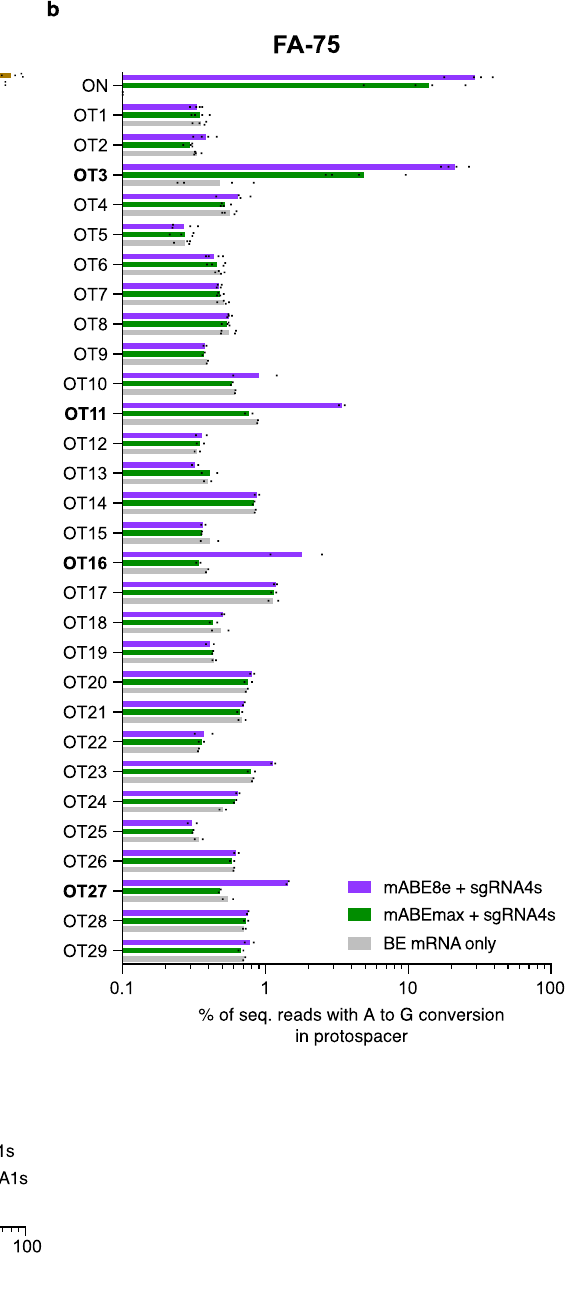
Fig. 4 | Off-target analysis at predicted loci in FA-55 and FA-75 LCLs. Compu- tationallypredictedoff-targetsitesareshownforFA-55sgRNA1 a andFA-75sgRNA4 b . The Sum of all NGS reads containing one or more A to G conversion in the protospacer are plotted. Each biological replicate is shown by a dot and bars representmeanofampliconNGSeditinglevelsfromallreplicates.OT3,OT11,OT16,